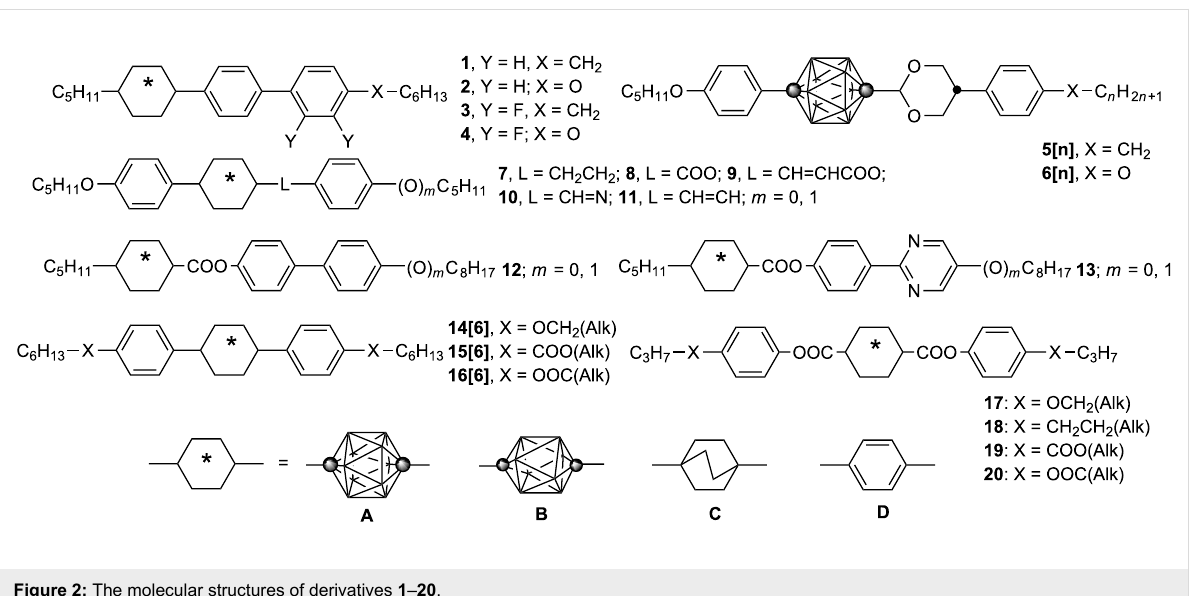
shielding of a lateral substituent [8,16,20] and chirality transfer phenomena [17]. Results of these studies are important for the design of new materials and optimizing of their properties for